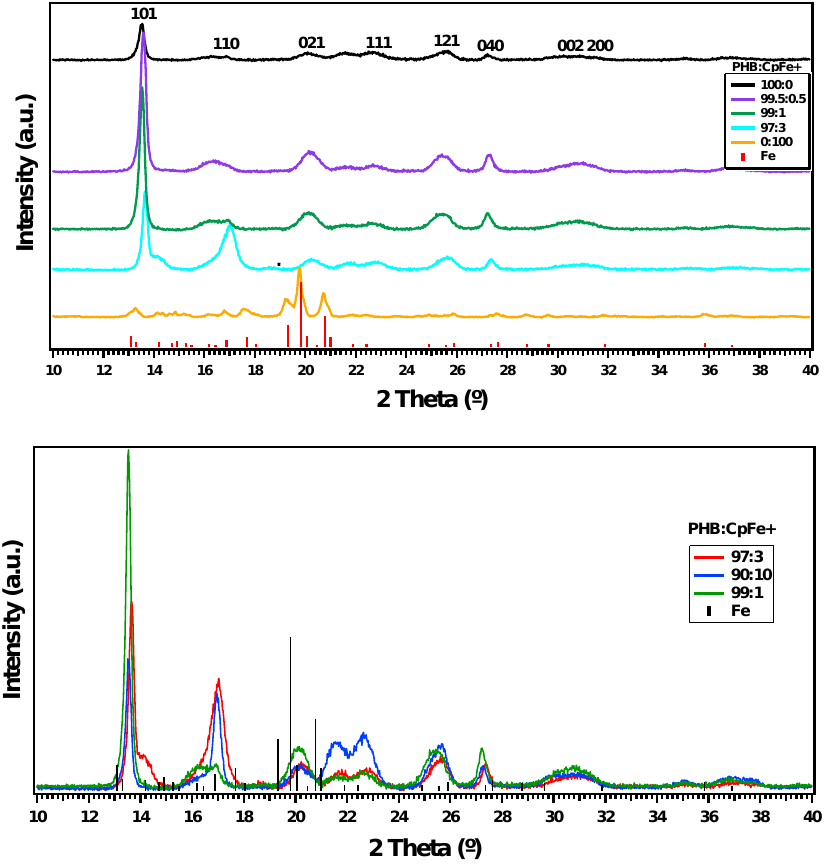
Figure 4. XRD pattern of pure PHB and PHB/ CpFe + nanocomposites with ratios of 100:0, 99.5:0.5, 99:1, 97:3 respectively ( top ). XRD pattern of a higher ratio of CpFe + 1%, 3%, and 10% ( bottom ).